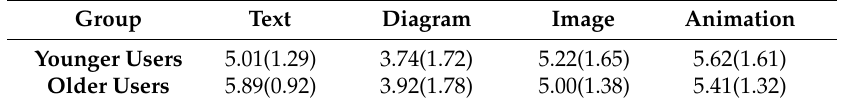
Table 20. Means and standard deviations for screen. (standard deviation in parentheses, unit: points; seven-point Likert